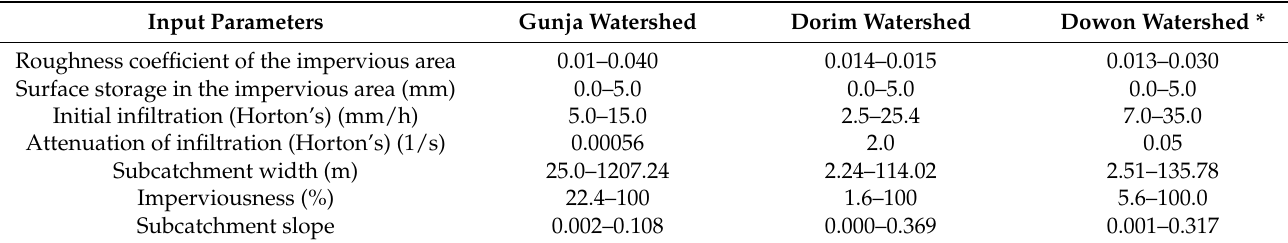
Table 2. SWMM model input data configuration.